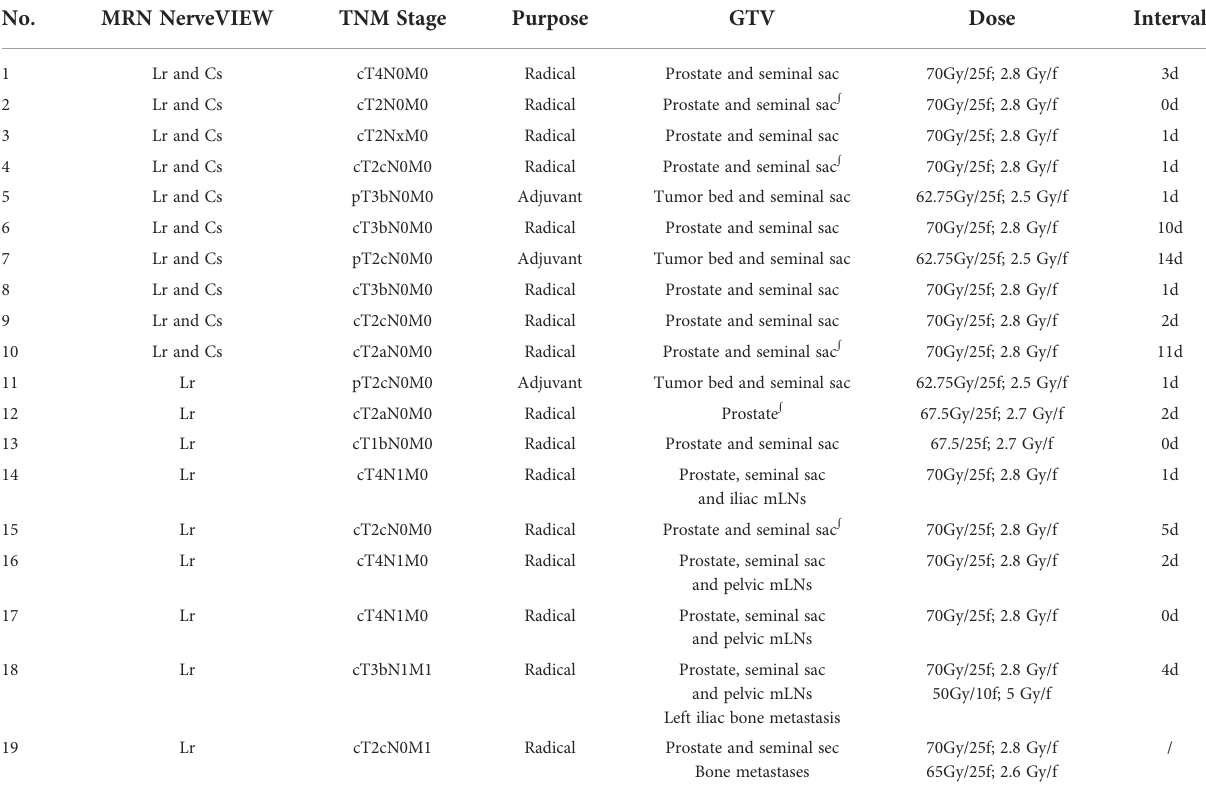
TABLE 1 Participants, tumor, imaging, and